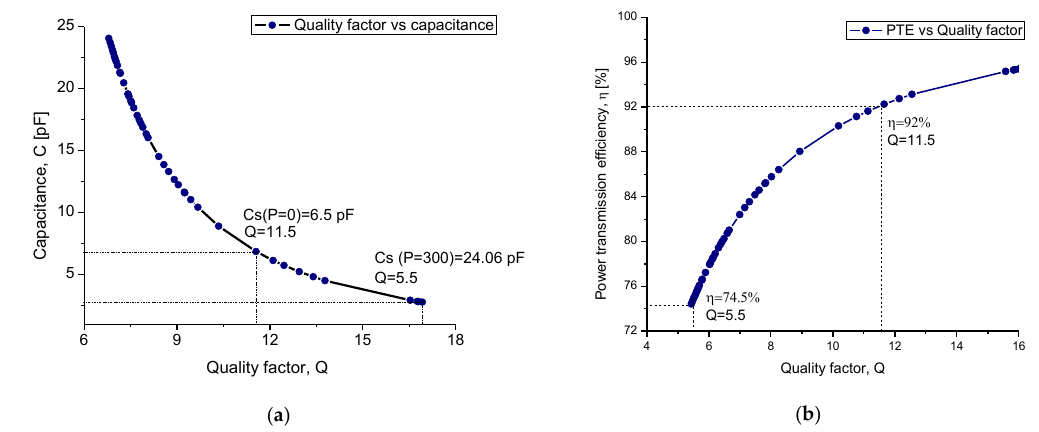
Figure 7. ( a ) The quality factor as a function of the capacitance variations in the touch mode capacitive pressure sensor (TMCPS). ( b ) The relationship between the internal quality factor and the power transmission efficiency (PTE) system. Table 2. Analytical results for the designed internal and external coils.